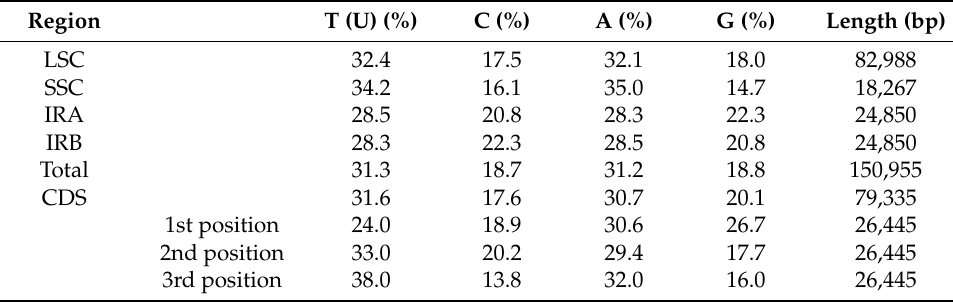
Table 1. Base composition in the A. annua chloroplast